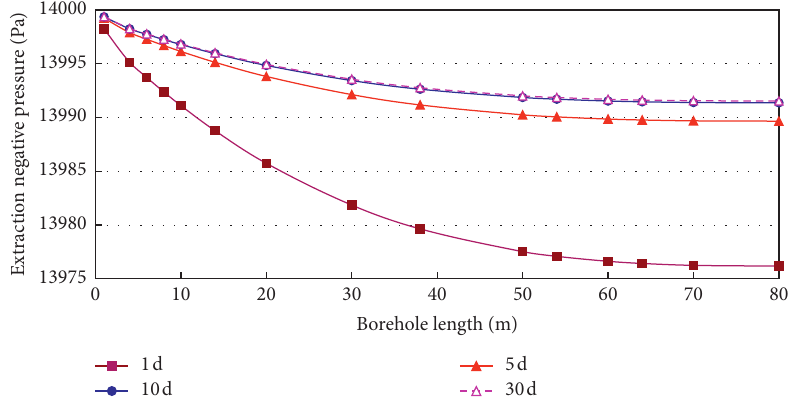
Figure 8: The gas extraction negative pressure distribution of complete hole.